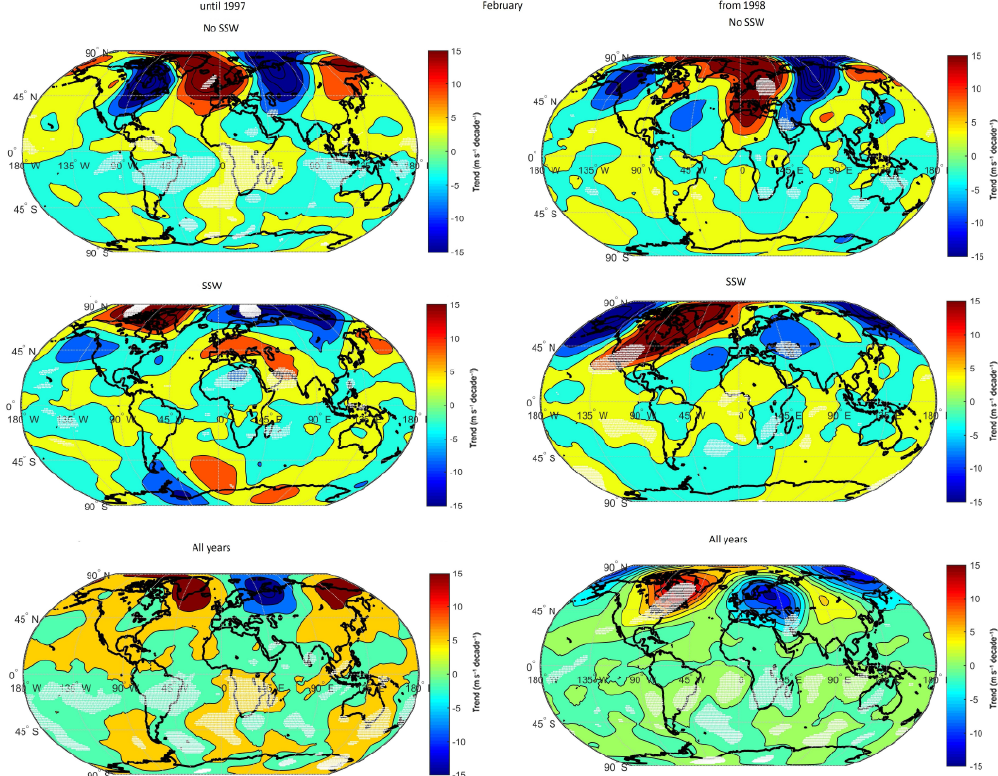
Figure 14. Meridional wind trends (ms − 1 decade − 1 ) for February for years without SSW (top panels), years with SSW (middle panels) and all years (bottom panels) at 10hPa from the MERRA reanalysis. Left panels show 1979–1997 and right panels show 1998–2015. Statistical significance (95%) is highlighted by white